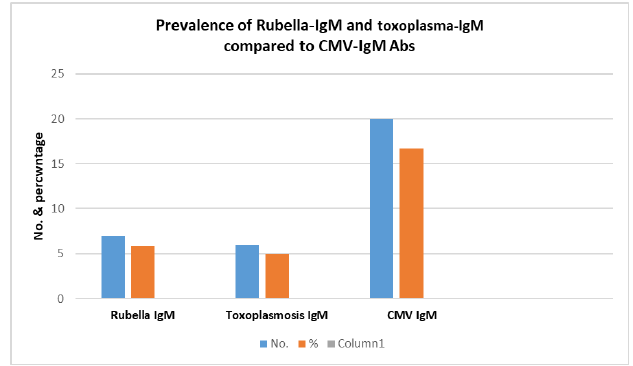
Figure 1: Prevalence of Rubella-IgM and toxoplasma-IgM compared to CMV-IgM